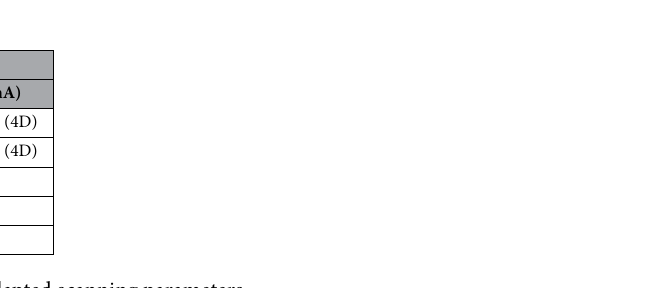
Table 2. Body mass index (BMI)-adapted scanning